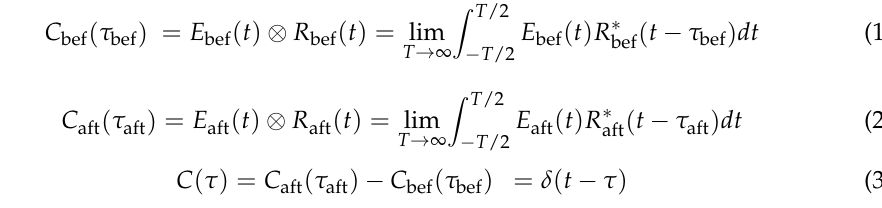
Figure 5. Intrusion detection algorithm of the proposed combined sensing system.